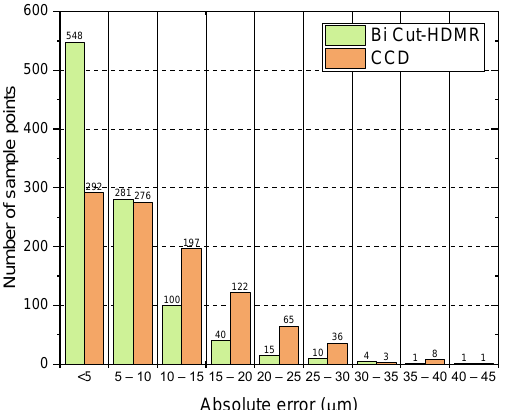
Figure 7. Absolute error of Bivariate Cut-HDMR and CCD of 1000 MCS.